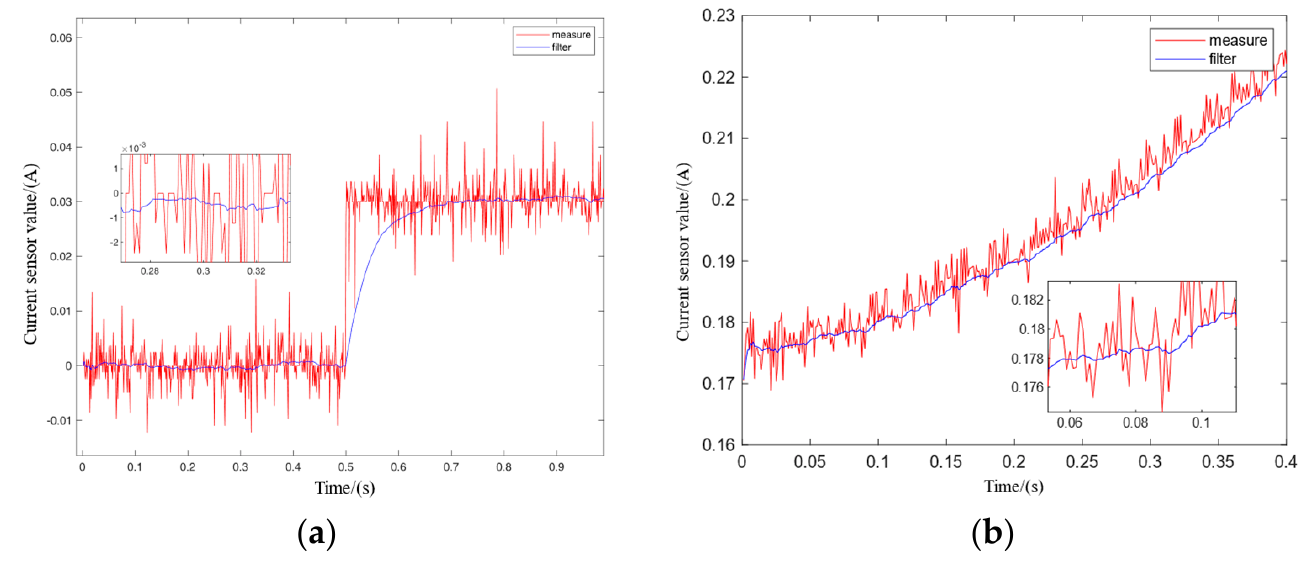
Figure 13. Kalman filter diagram of current sensor fault. ( a ) Kalman filter diagram of current sensor abrupt fault; ( b ) Kalman filter diagram of current sensor incipient fault.